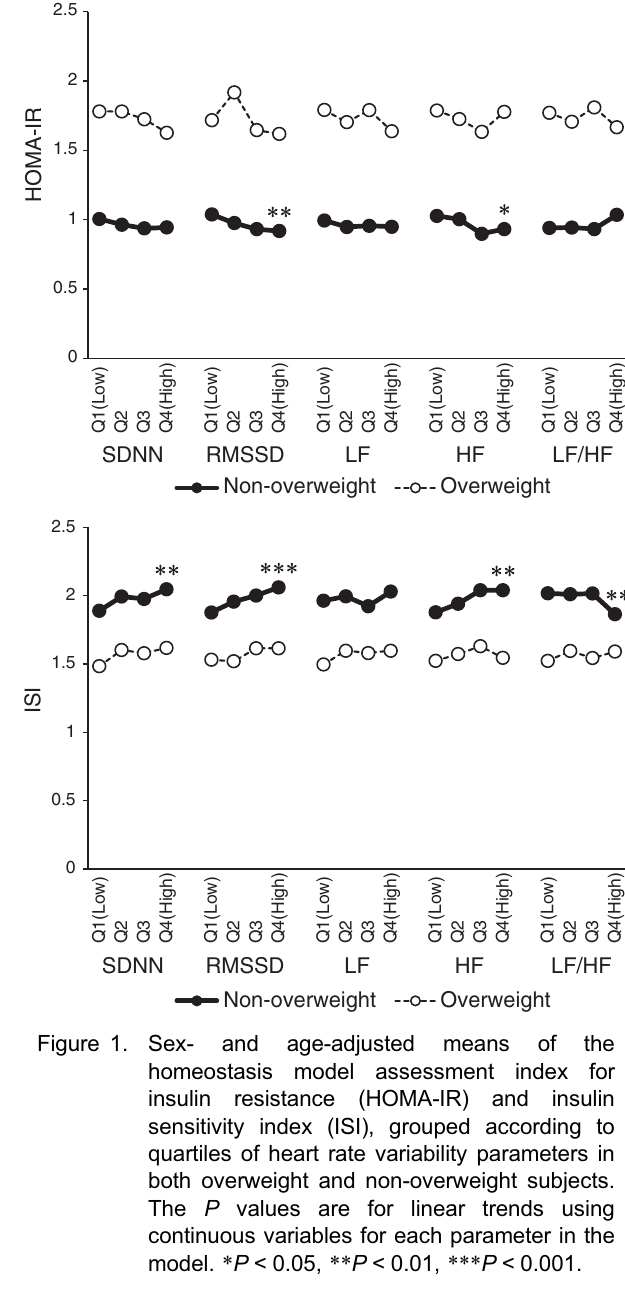
Quartile of SDNN P for